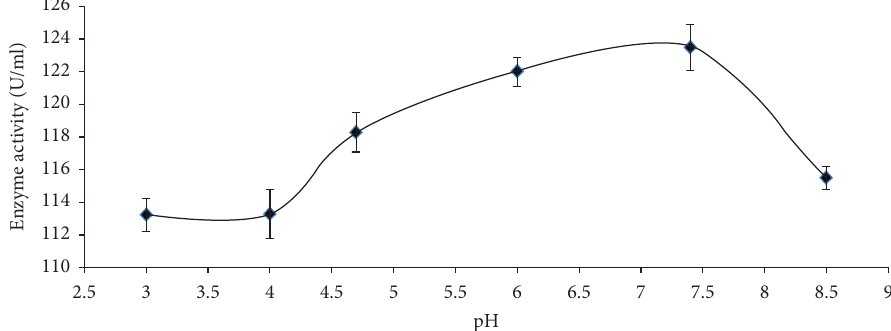
Figure 5: Effect of initial pH in the medium on the dextranase production from Talaromyces sp. at the second day of